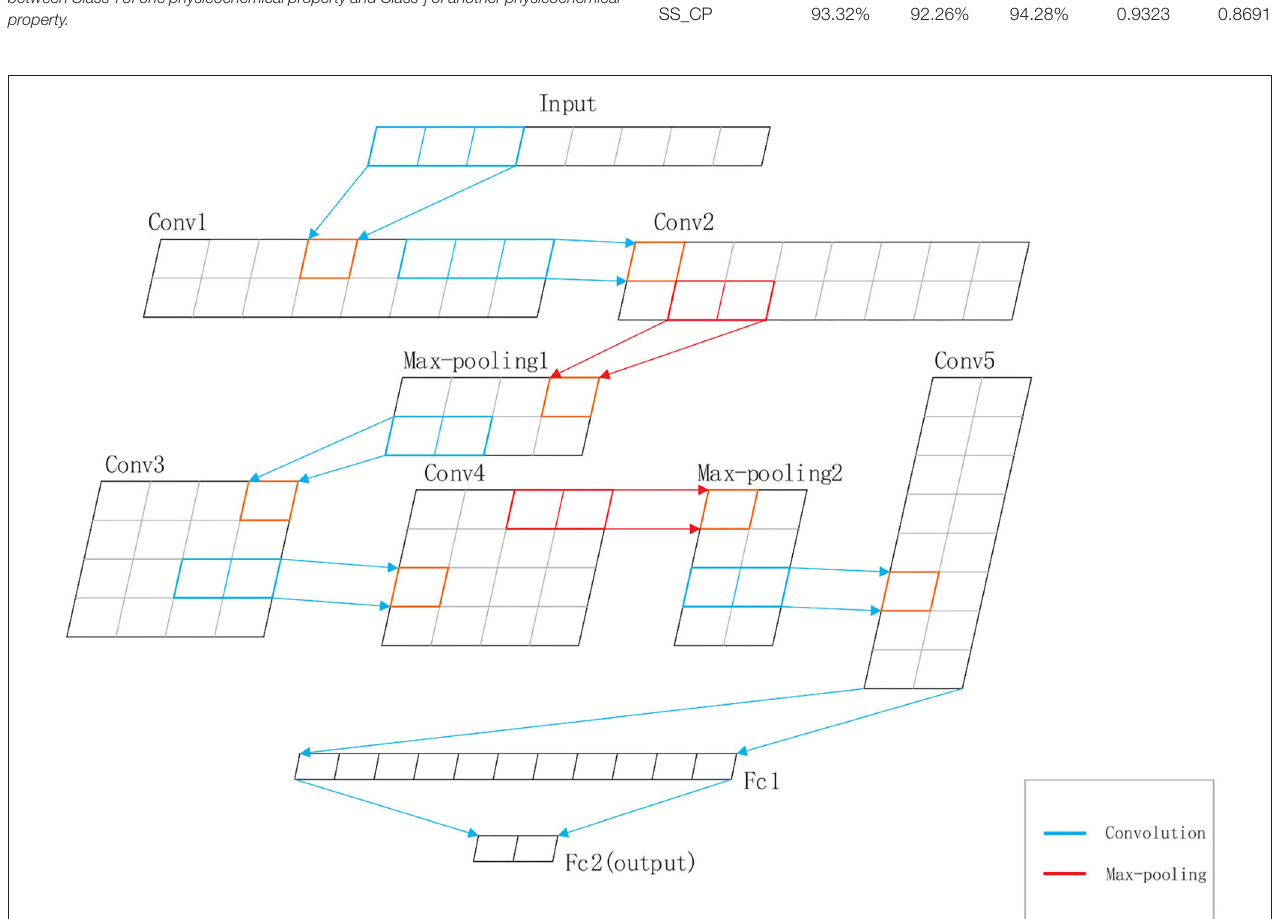
FIGURE 2 | The structure of the DCNN used in DeepRTCP. The DCNN has five convolutional layers: Conv1, Conv2, Conv3, Conv4, and Conv5, five batchnormalization layers, two max-pooling layers: Max-pooling1 and Max-pooling2, and two fully connected layers: Fc1 and Fc2. Fc2 is the output layer. The blue line represents the convolution. The red line represents the max-pooling.